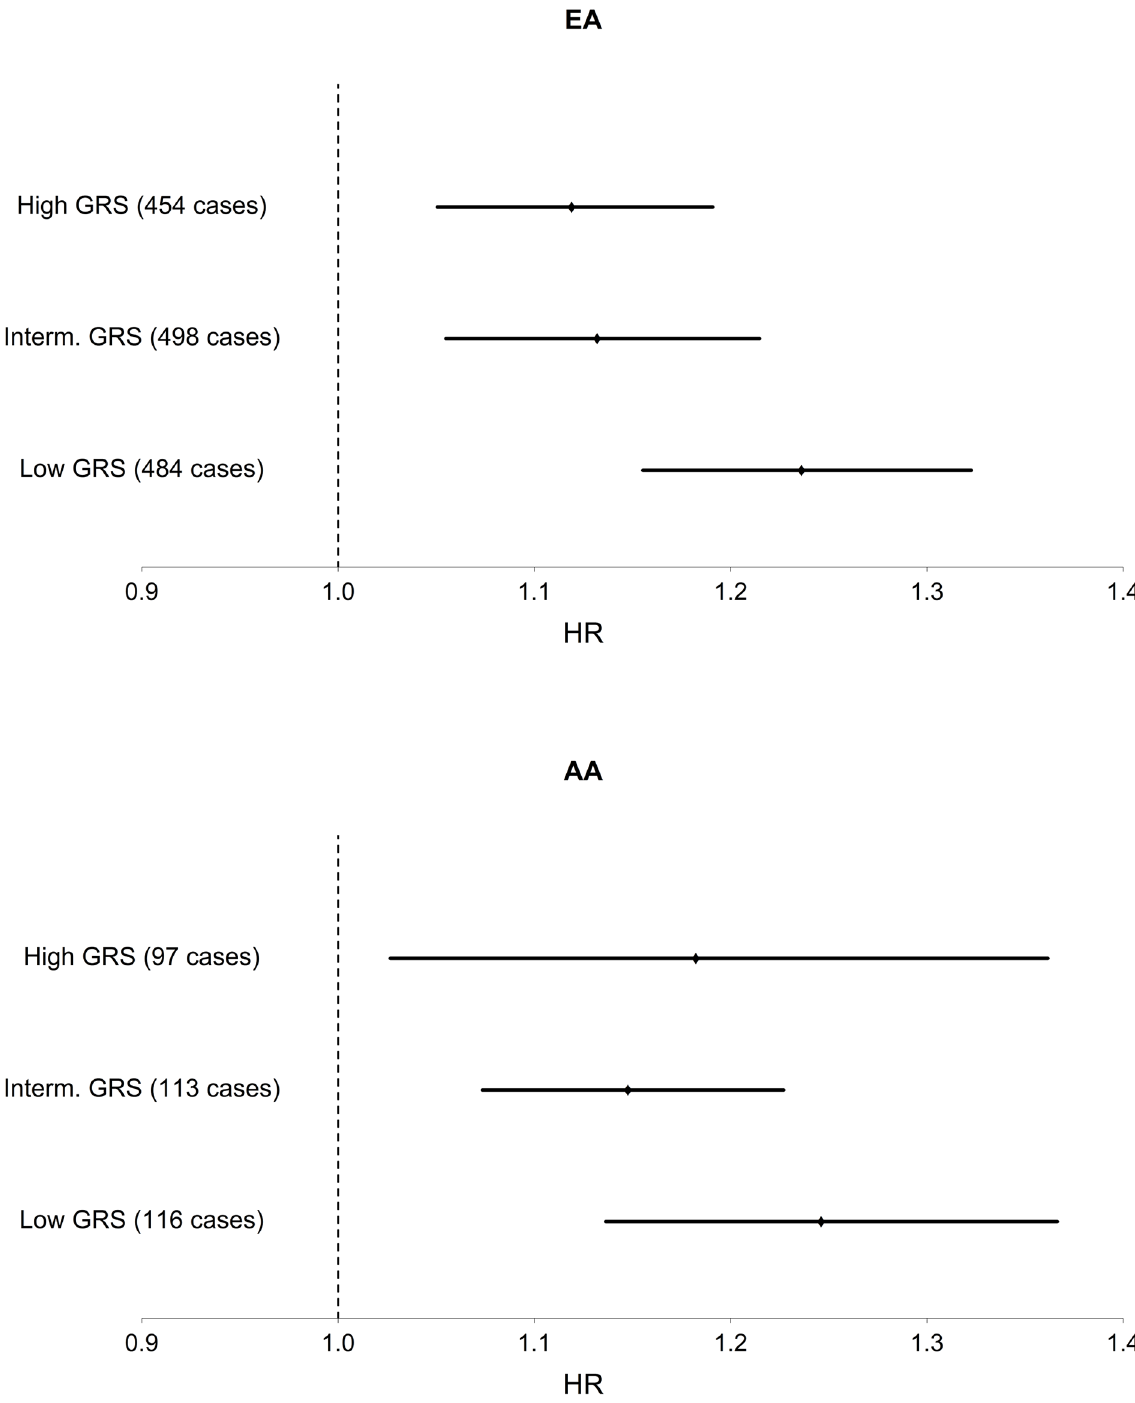
Fig 2. Association of TG with T2D in each of three strata of TG GRS, in EA and AA. Hazard ratios and 95% CI are shown. Covariates include age, sex, BMI, TG, and HDL.